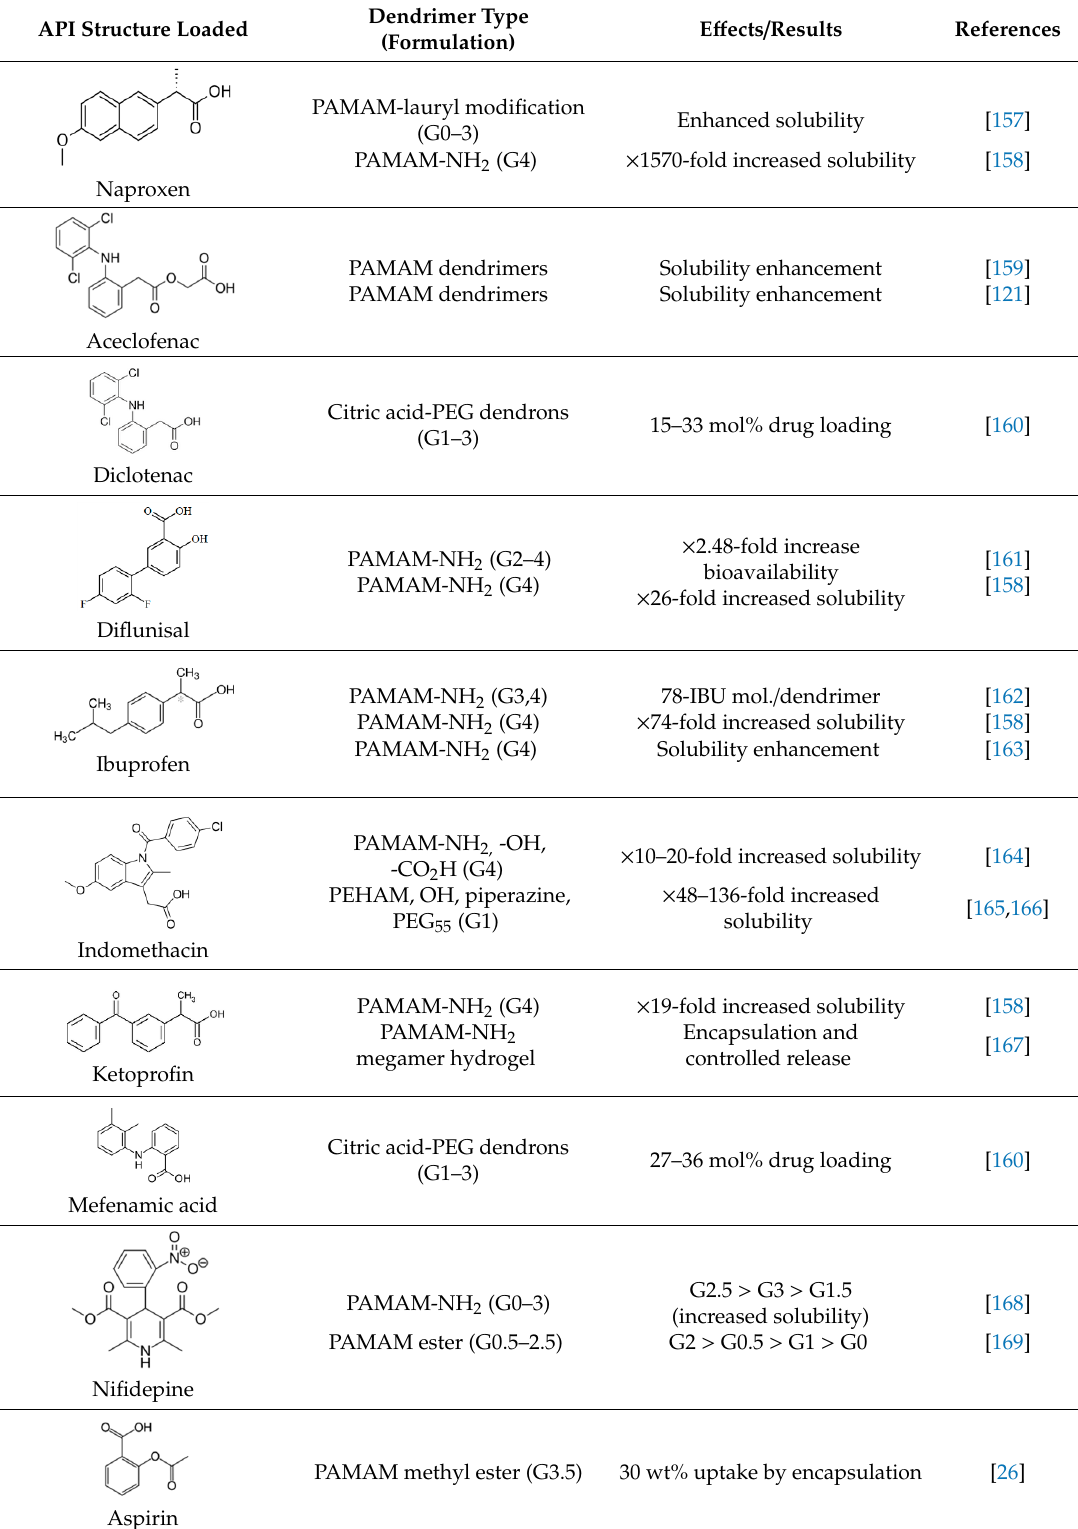
Table 3. Anti-inflammatory Drugs.